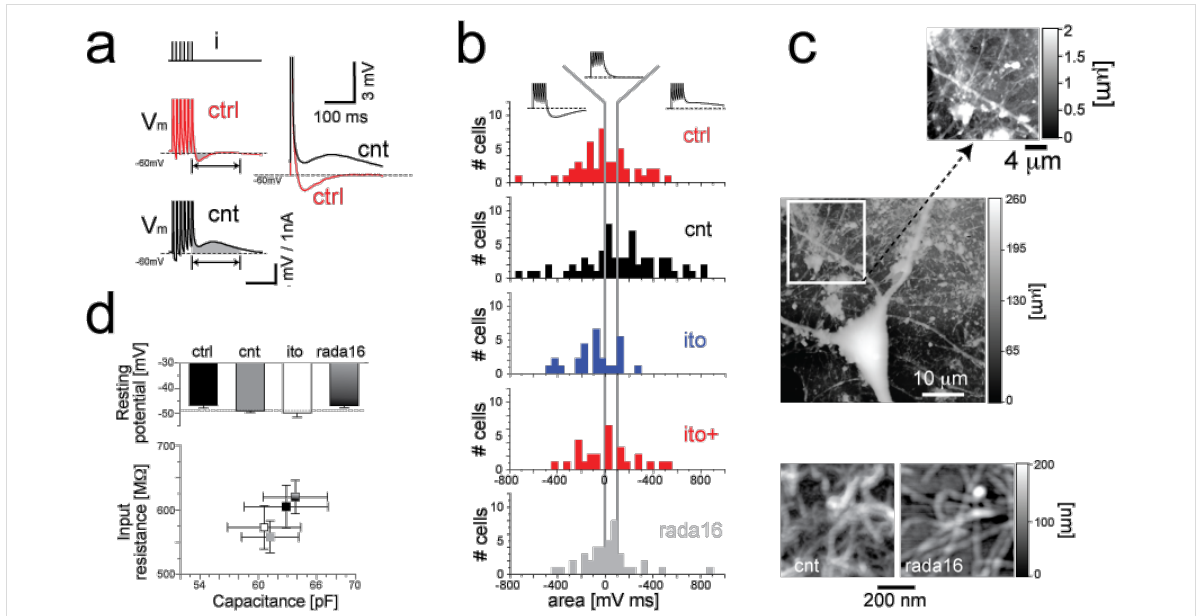
Figure 3: CNTs affect single-neuron excitability, inducing depolarising after-potentials (a). This behaviour is specifically attributable to CNTs, as it has been observed neither for cells grown on smooth and electrically conducting indium tin oxide substrates (ito) nor on electrically-insulating RADA16 peptide thin-films (b), characterised by a similar nanoscale roughness s CNTs (c). The culture substrates do not alter the electrical passive properties of neuronal membranes (d). Reproduced and modified from [121] with permission. Copyright 2009 Nature Publishing